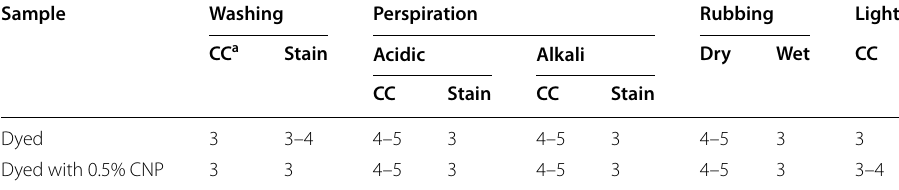
Table 5 Colorfastness to washing, perspiration, rubbing and light of cotton dyed with Euphorbia with and without cellulose nanoparticles (CNP) Sample Washing